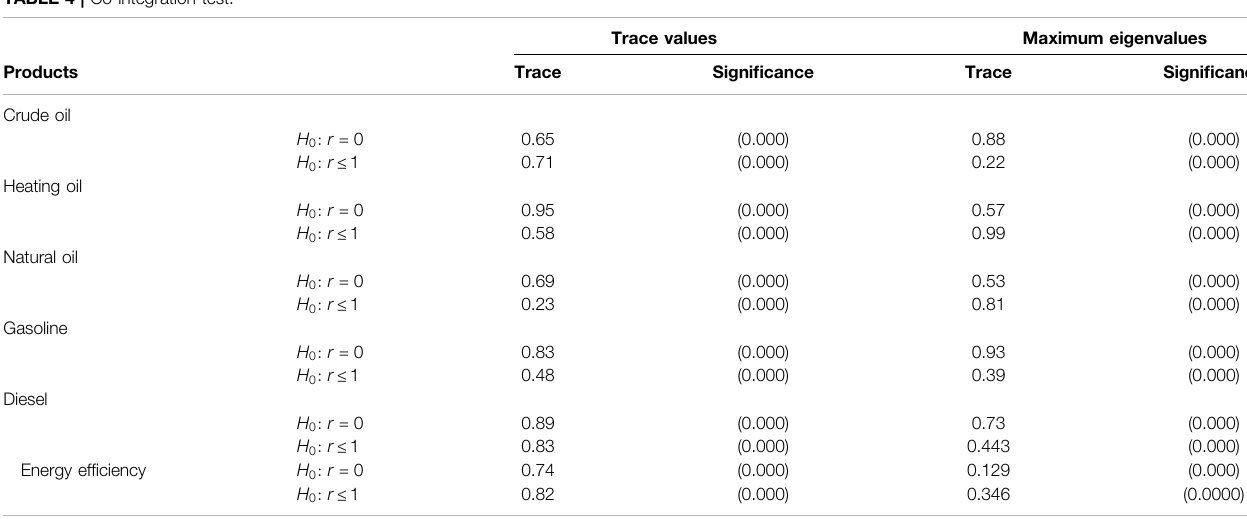
TABLE 4 | Co-integration test.